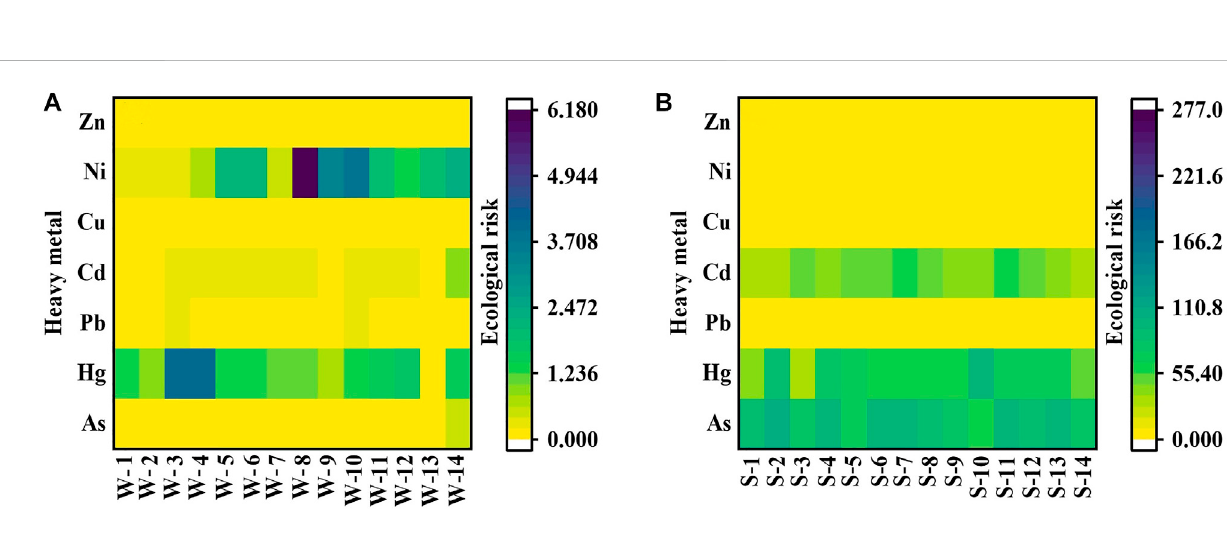
Heatmaps of the potential ecological risk index for heavy metals in water (A) and sediment (B)